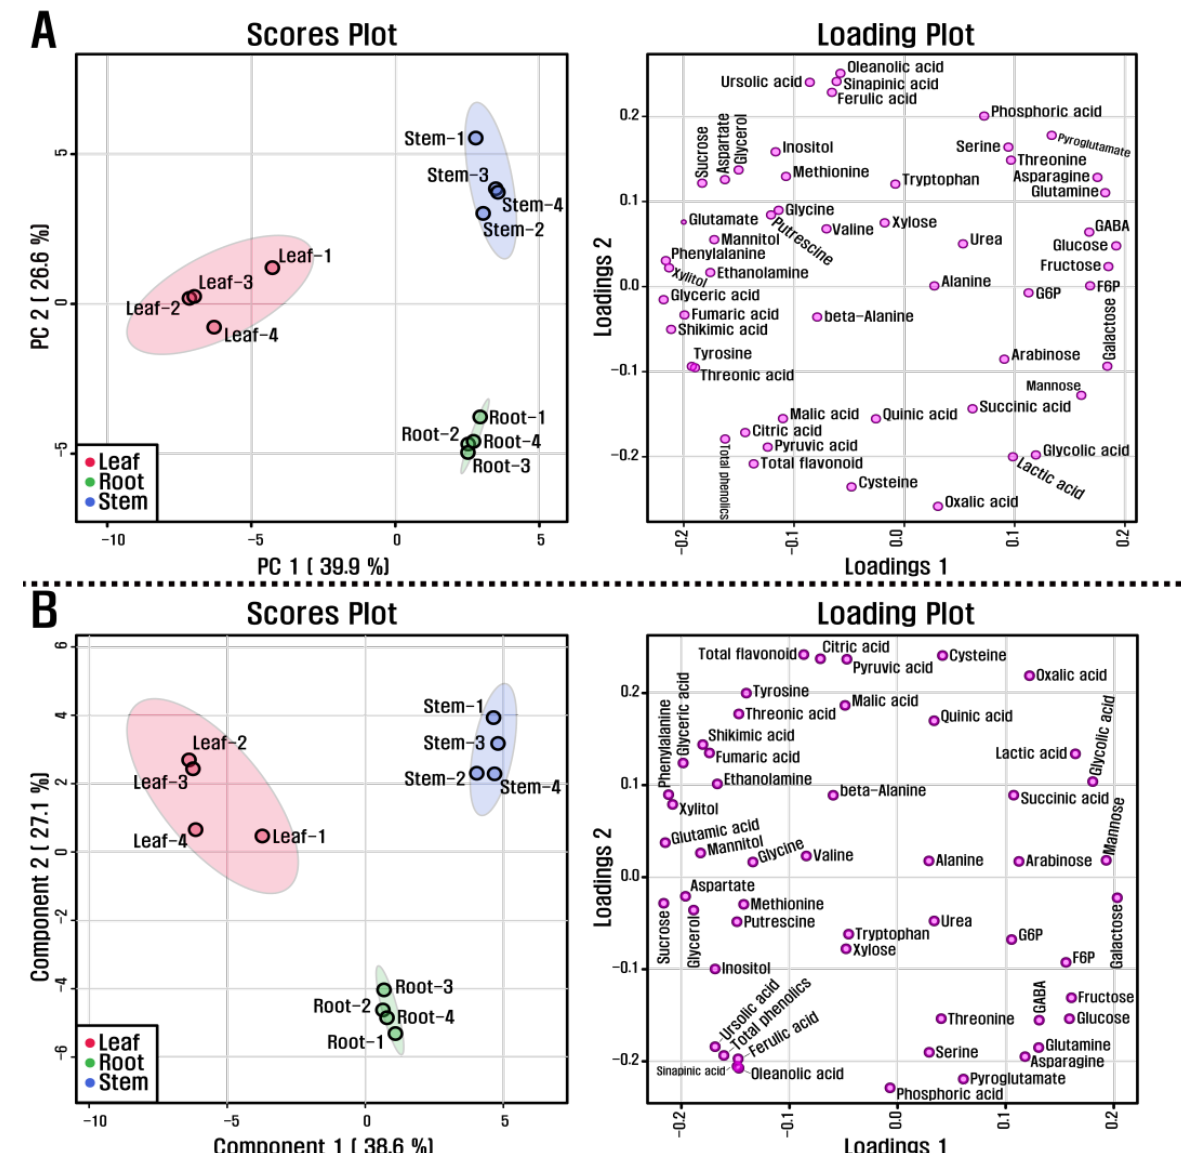
Figure 5. ( A ) scores and loading plots of PCA model and ( B ) scores and loading plots of PLDA model obtained from metabolites detected in different organs of L . pubescens using HPLC and GC-TOFMS.